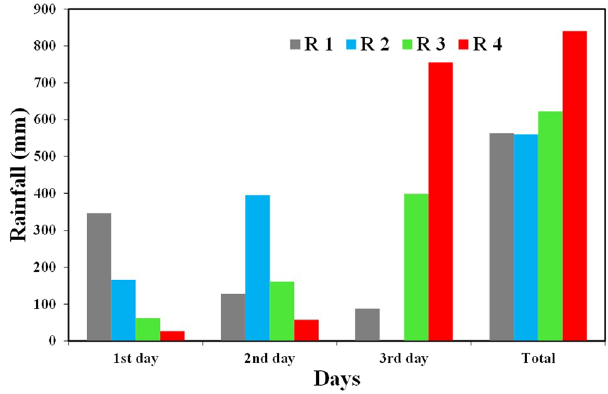
Figure 6. Four types rainfall for the flood inundation assessment.